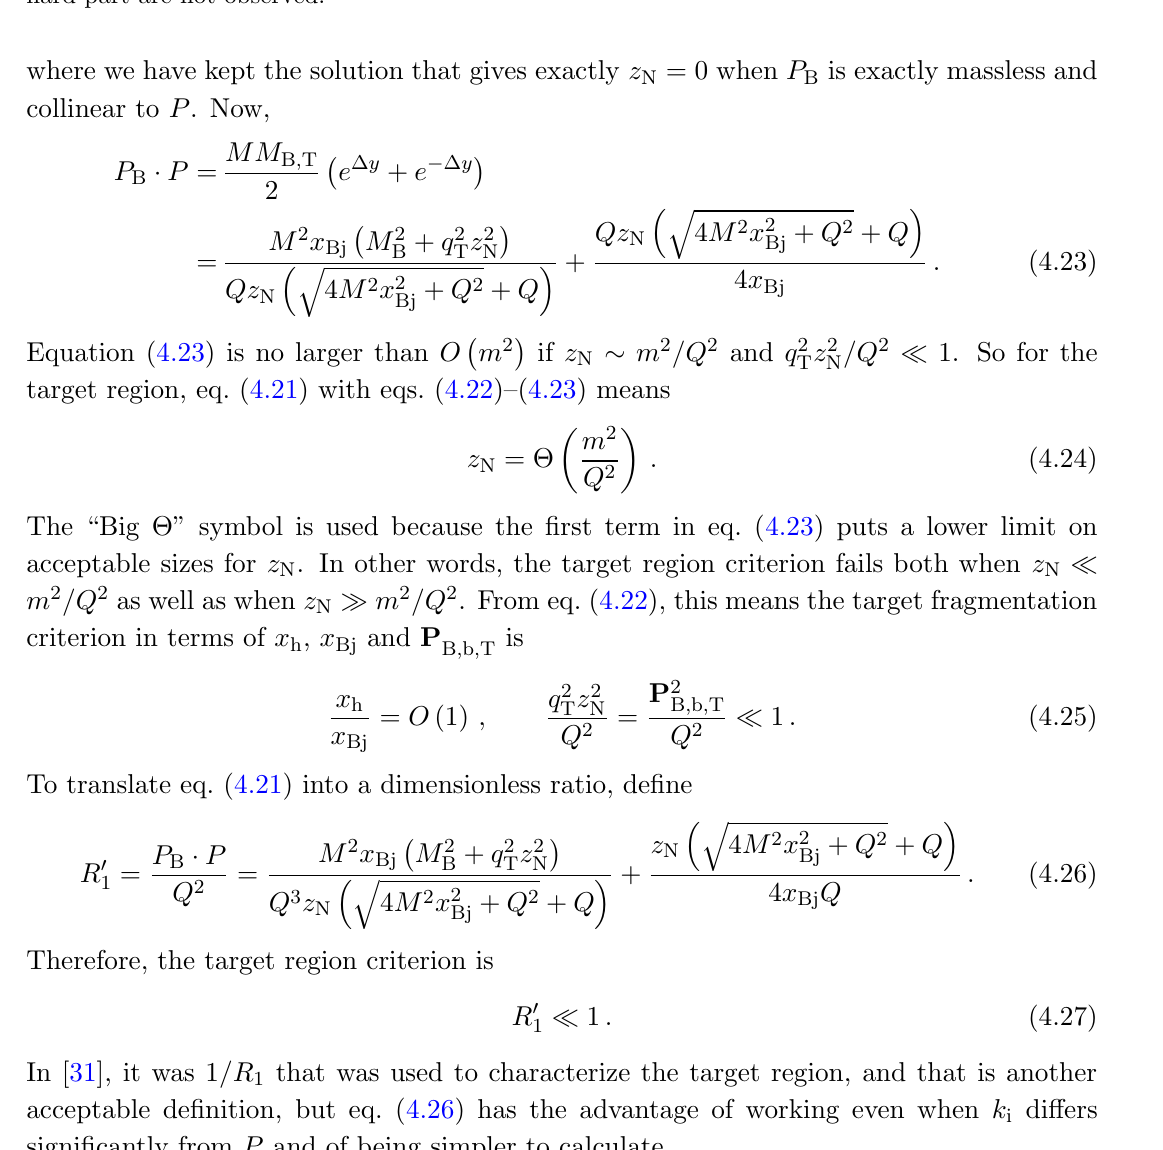
Figure 7 . A hadron produced in the target region | see eq. (4.21). Hadrons produced from the hard part are not